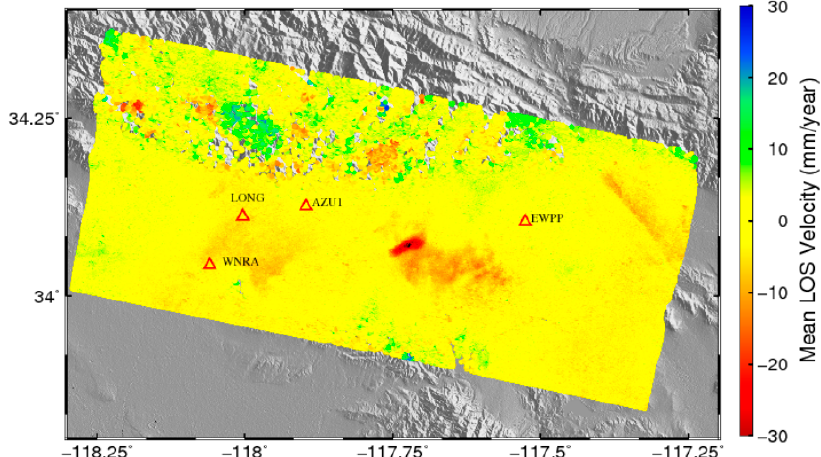
Figure 4. Mean displacement rates (mm/year) of PS in the Line of Sight (LOS) direction after removal of DEM errors and tropospheric phase delays in the study area (The red triangles represent the locations of GPS sites and the background is the SRTM DEM).